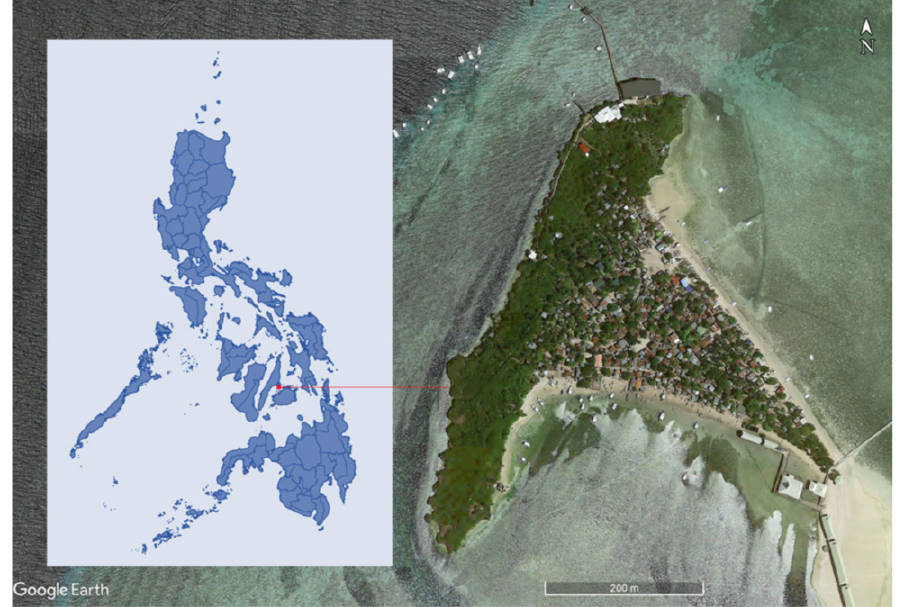
Figure 2. Gilutongan Island (pop. 1875 in 2017), as shown in the satellite imagery above, is located in the central part of the Philippines (inset map). The island is not connected to the national grid, as it is a remote area and is considered as unviable for grid electrification (satellite imagery from Google